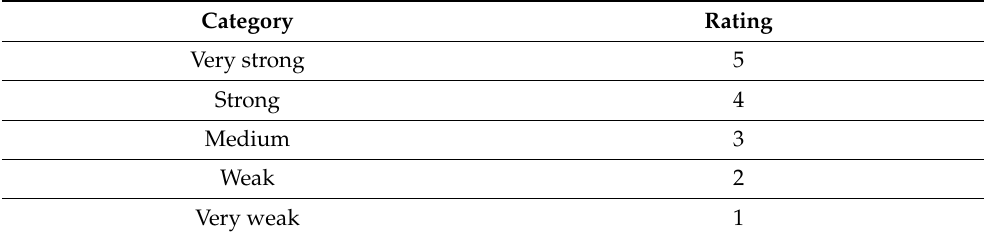
Table 4. Quantification of the interdependencies of enablers (Likert 5-point scale). Category Rating Very strong Strong